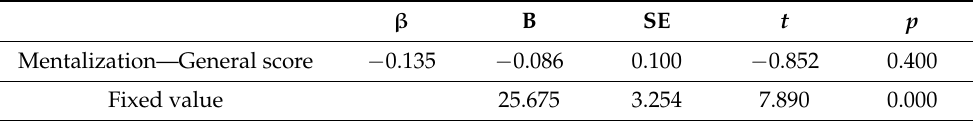
Table 12. Predictors of positive redefinition. β B SE t